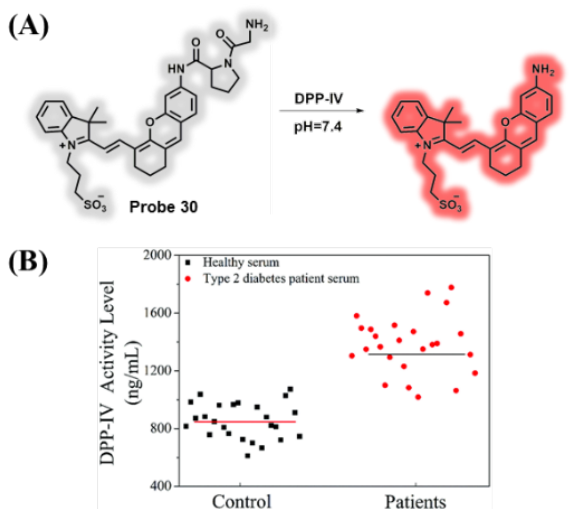
Figure 25. ( A ) Imaging mechanism of probe 30 ; ( B ) the DPP-IV activity levels in serum samples from the control group (healthy volunteers) and patient group. Adapted from Reference [120]. Copyright